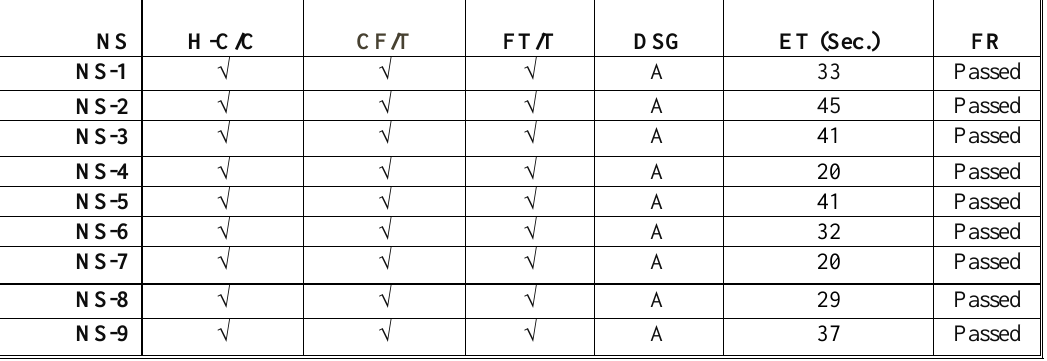
Table 2. Thermodynamic Stability Studies and Dispersibility Grades Results of Prepared LZL